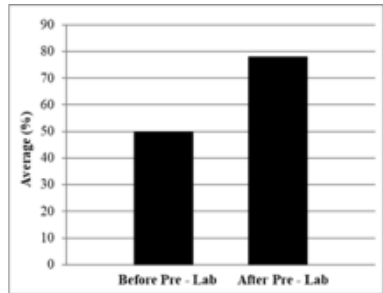
Figure 9. Responses from the Formation of Hydrogen experimental group on how well they understood endothermic/exothermic reactions before and after the pre-lab